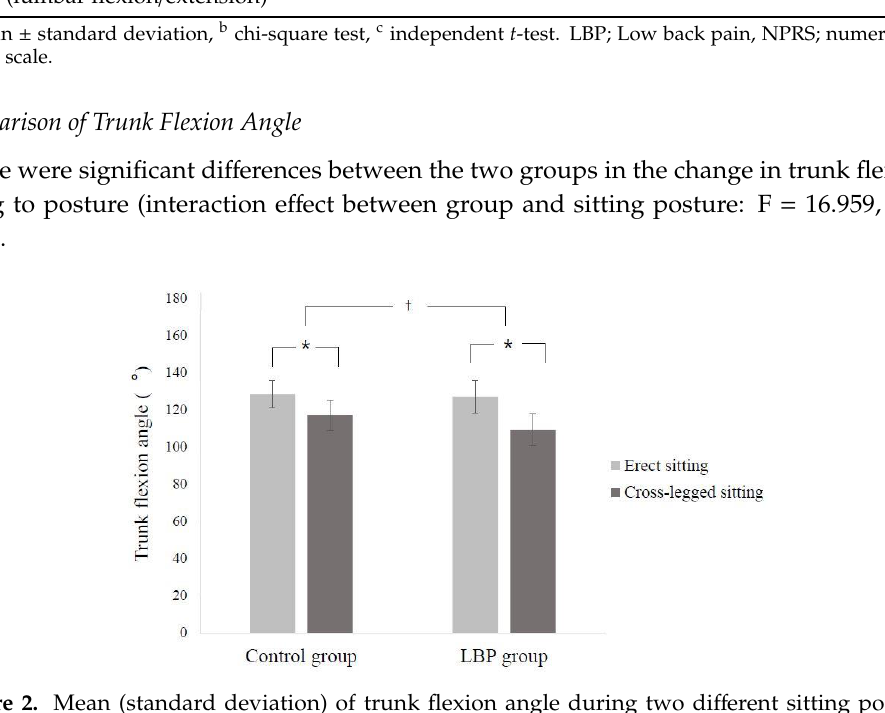
Figure 2. Mean (standard deviation) of trunk flexion angle during two different sitting postures. * Significantly different within the group. † Significantly different between groups.